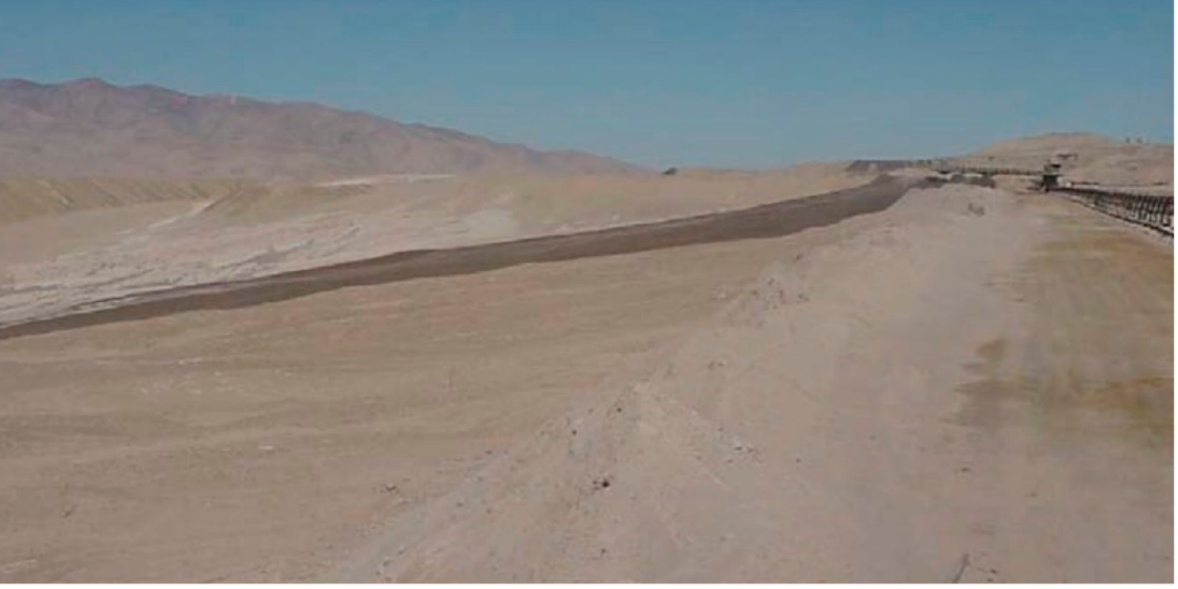
Figure 9. Mantos Blancos Disposal of Filtered Coarse Tailings with Mobile Stacker Conveyor and Tripper [12].